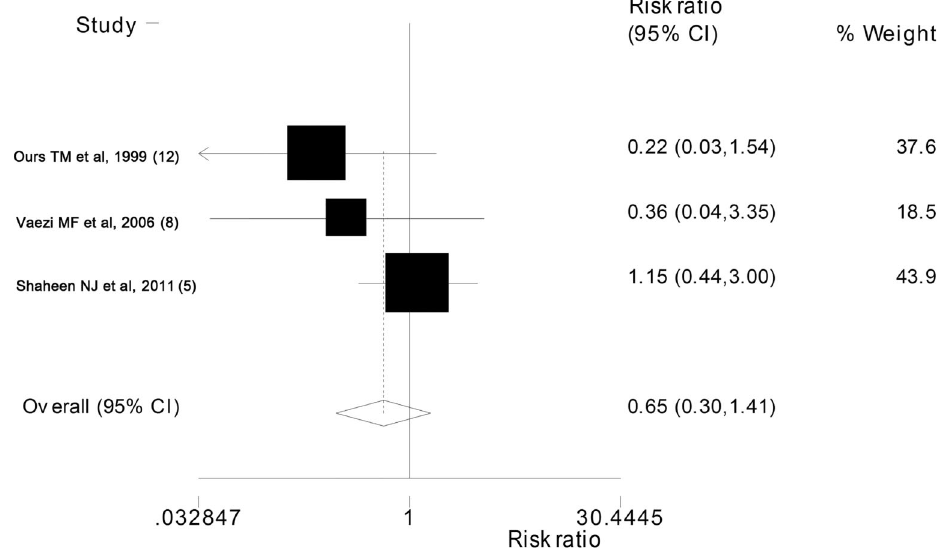
Figure 3. Forest plot showing the effect of PPIs on cough improvement. See Table 1 for reference